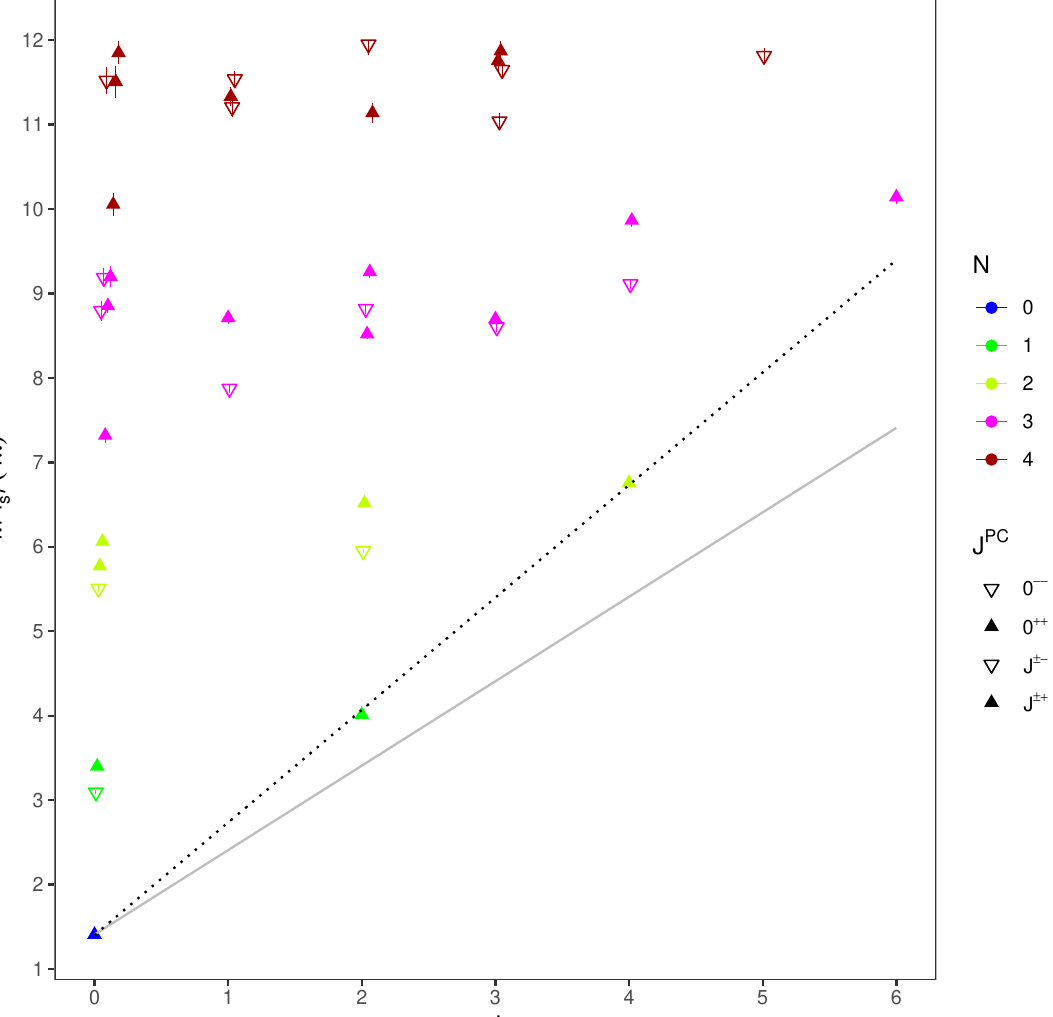
= 4 (cid:25) (1 : 40(4) + 1 : 35(4) J ). The s